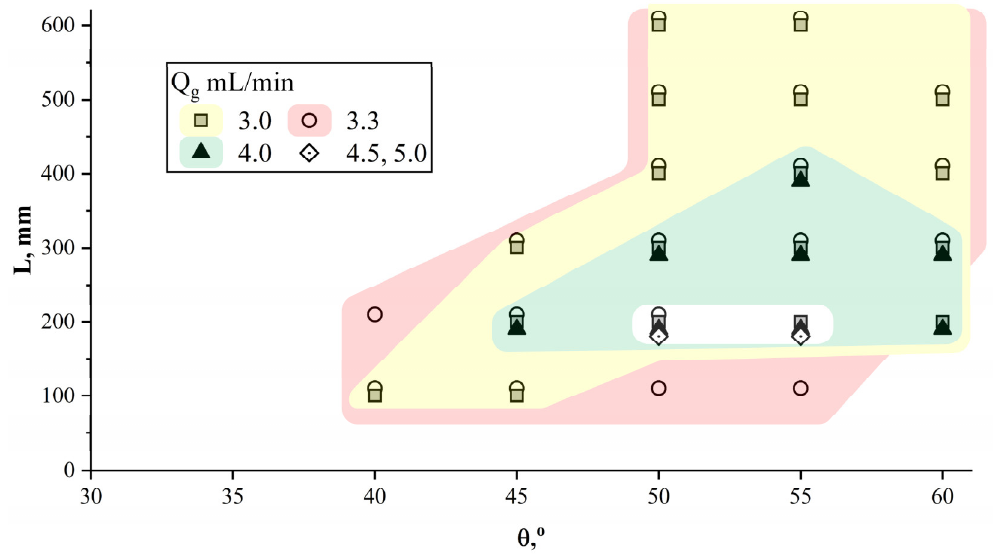
Figure 5. Bubble movement in modes without cluster formation (θ = 35°) and with cluster formation (θ = 50°); gas flow rate Q g = 3.3 mL/min.